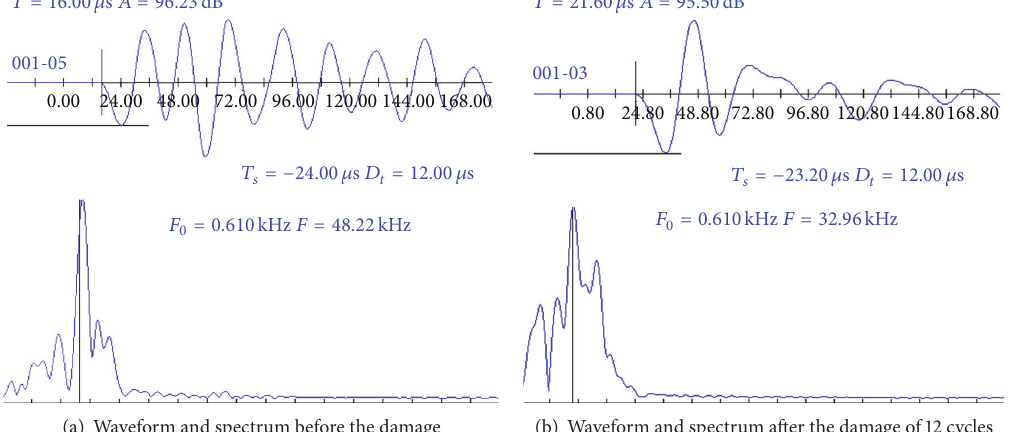
Figure 7: Waveform and spectrum before and after the